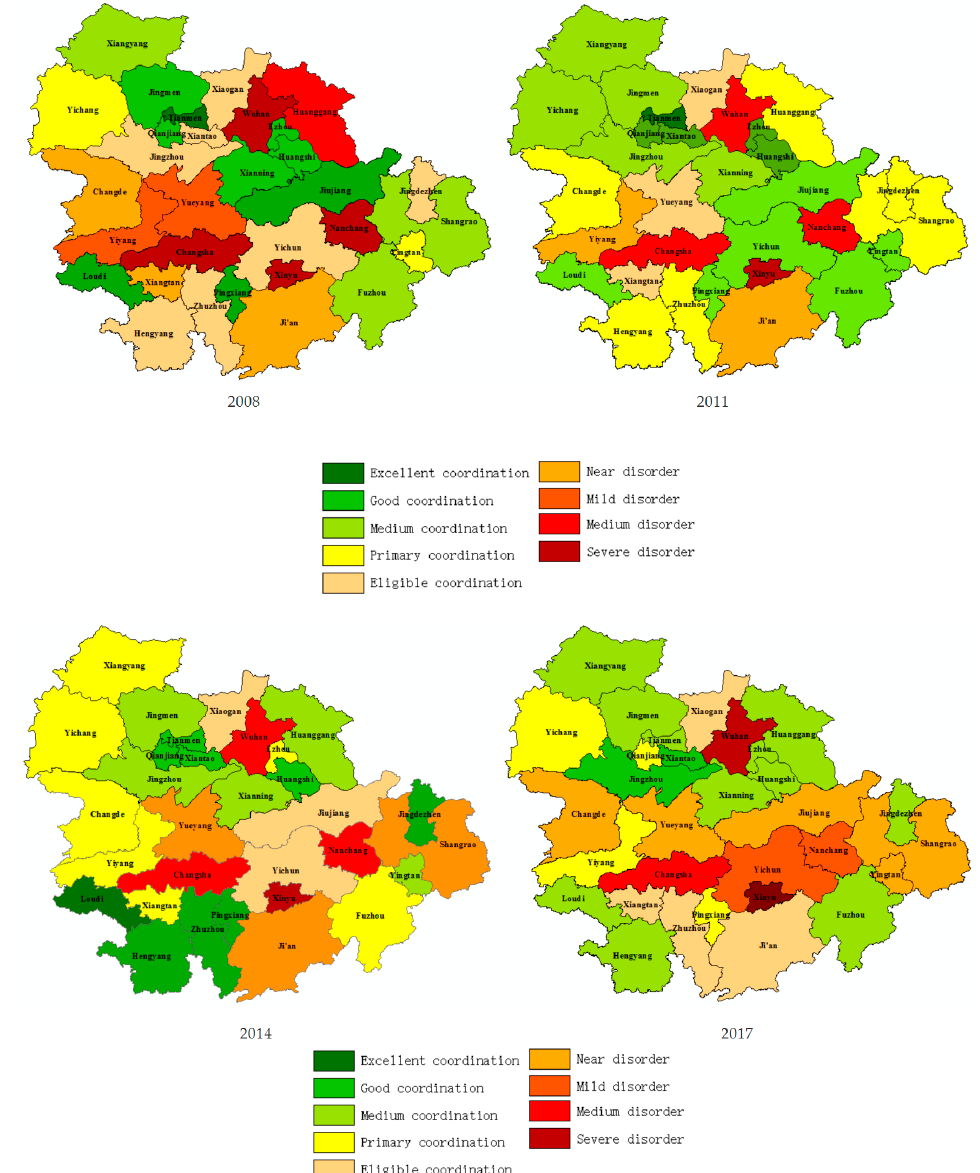
Figure 6. Spatial distribution of the dynamic coordination degree between the WRES and the HQEDS of the urban agglomeration in the middle reaches of the Yangtze River.